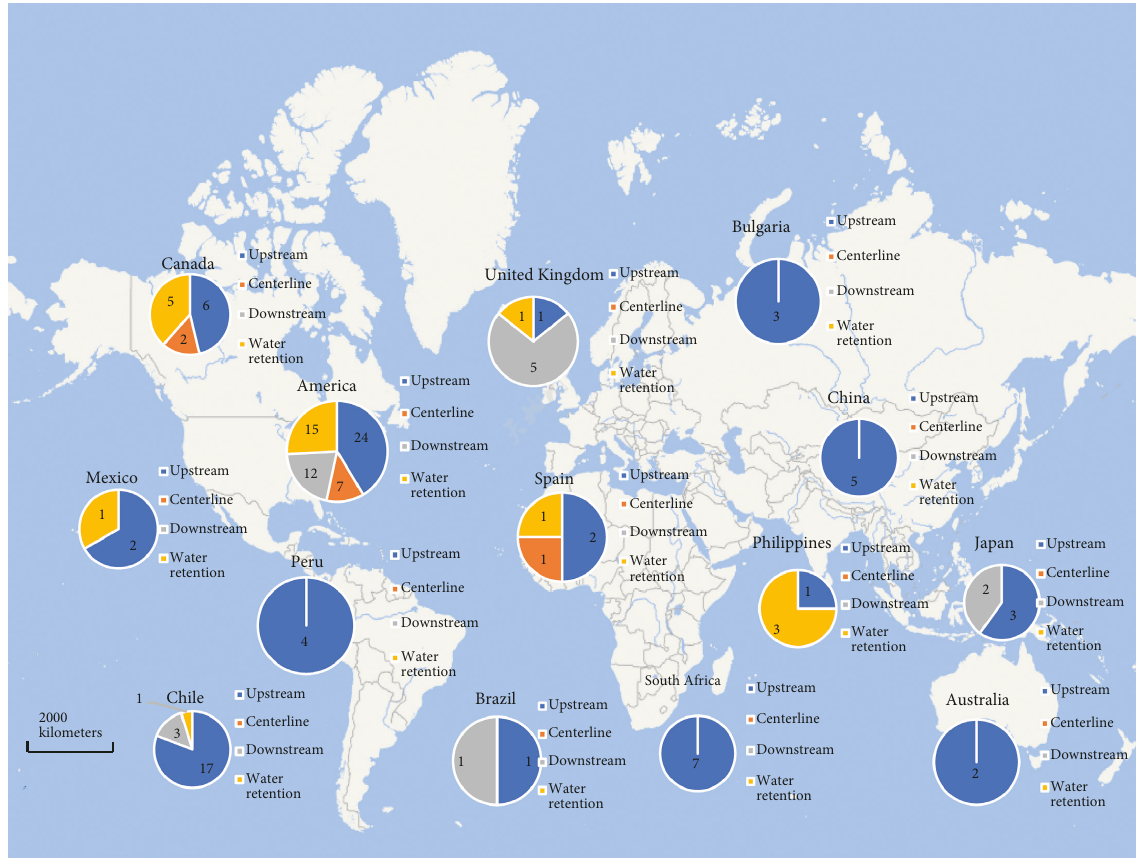
Figure 1: Number and types of tailings dam failures in several countries. Table 2: Example of tailings dam failure caused by